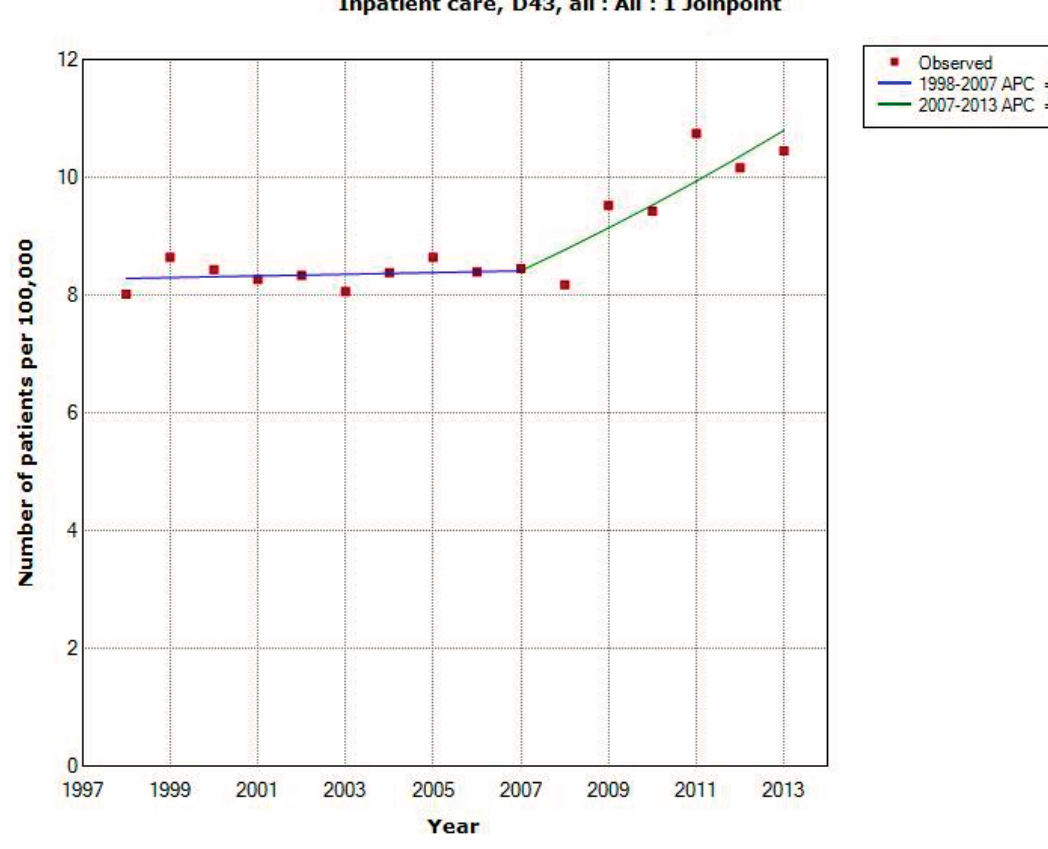
Figure 1. Joinpoint regression analysis of number of patients per 100,000 inhabitants according to the Swedish National Inpatient Register for both genders combined, all ages during 1998–2013 diagnosed with D43 = tumour of unknown type in the brain or CNS [27]. ^ Indicates statistically significant